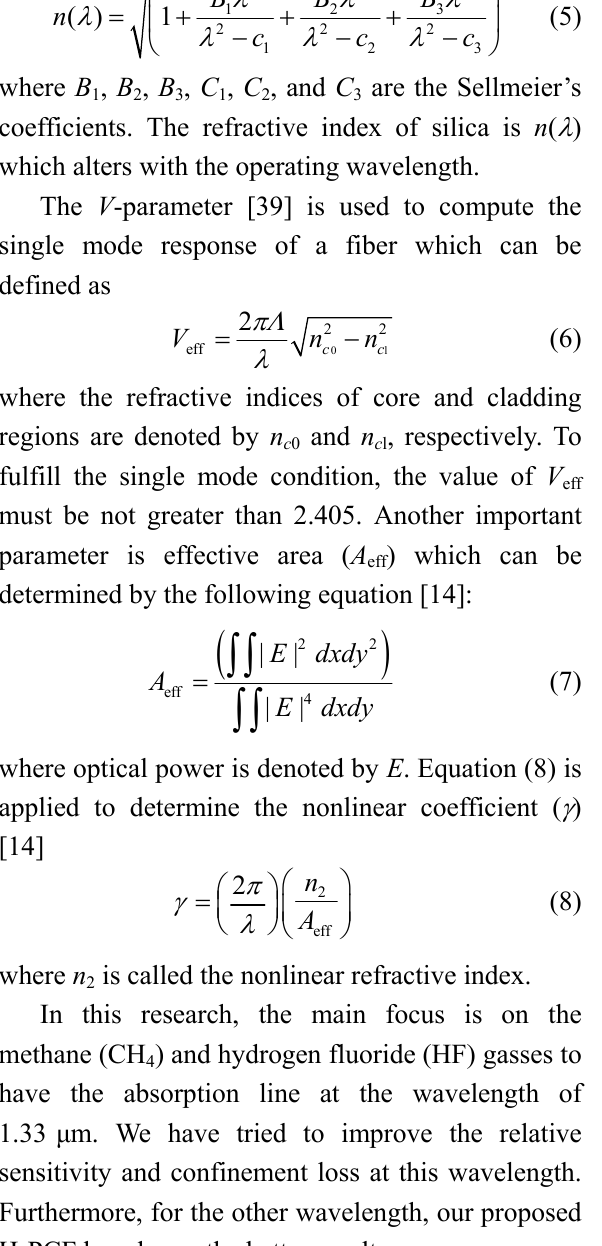
3(a)] and confinement loss versus wavelength curve [Fig. 3(b)] for the optimized parameters of